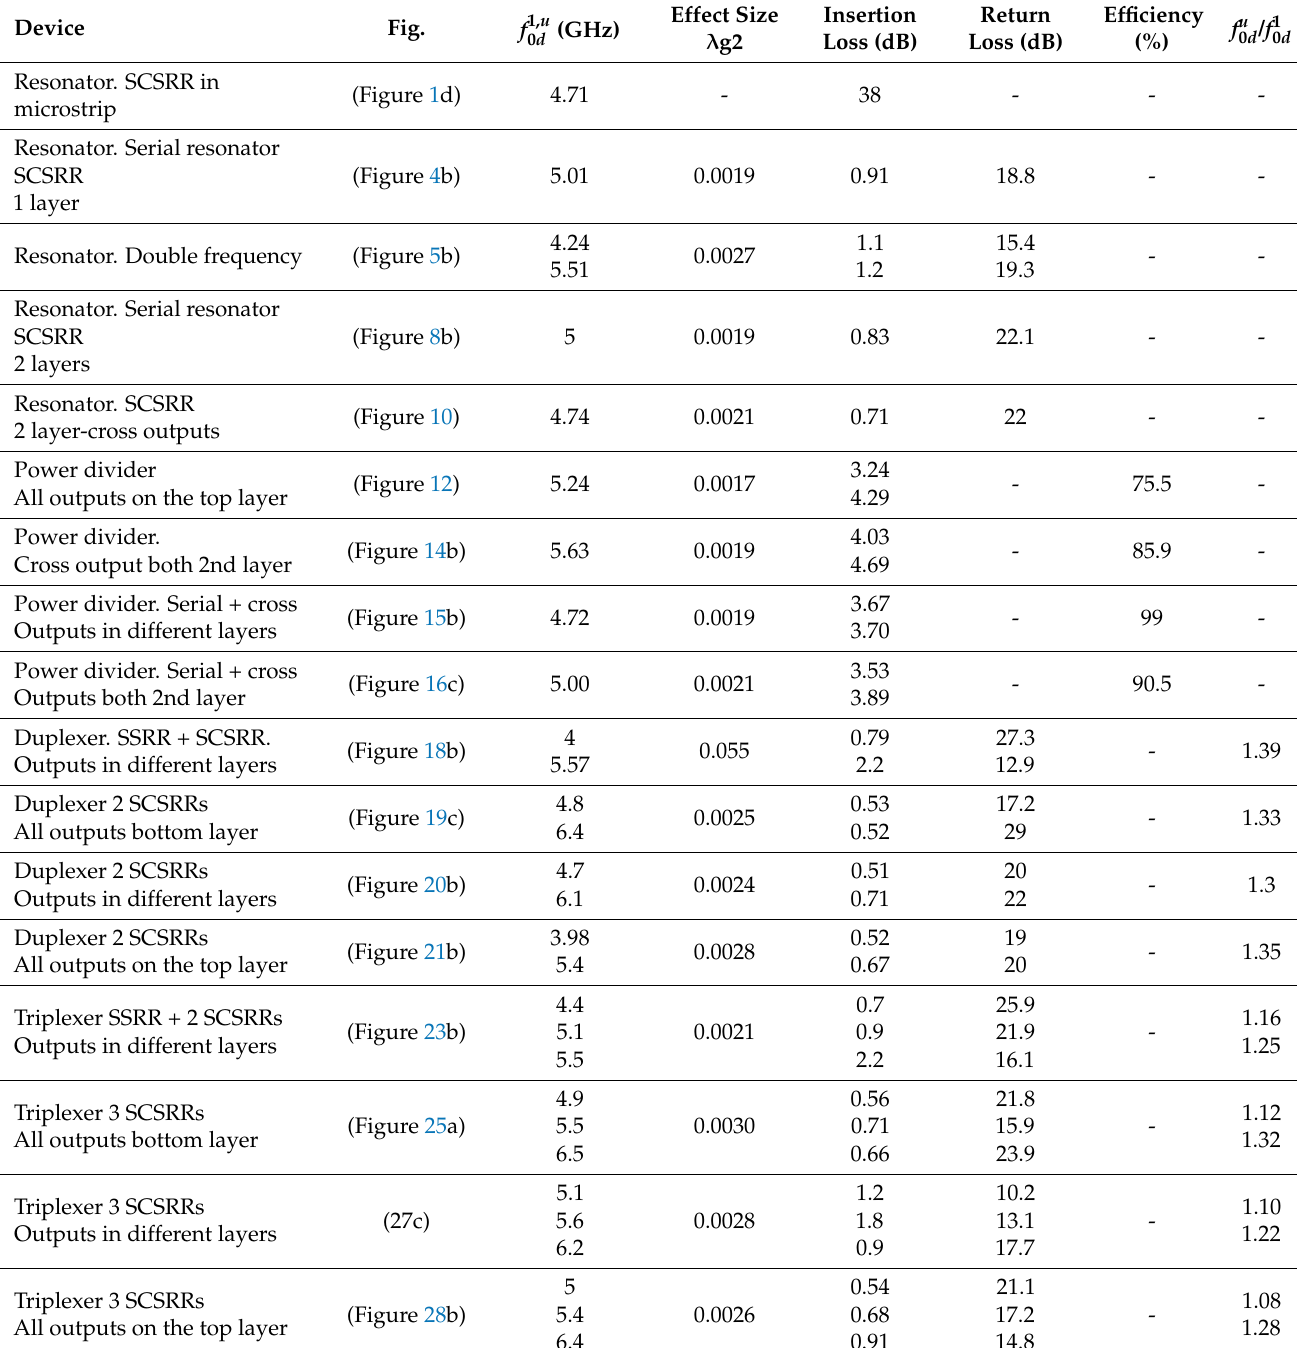
Table 7. Main figure proposed